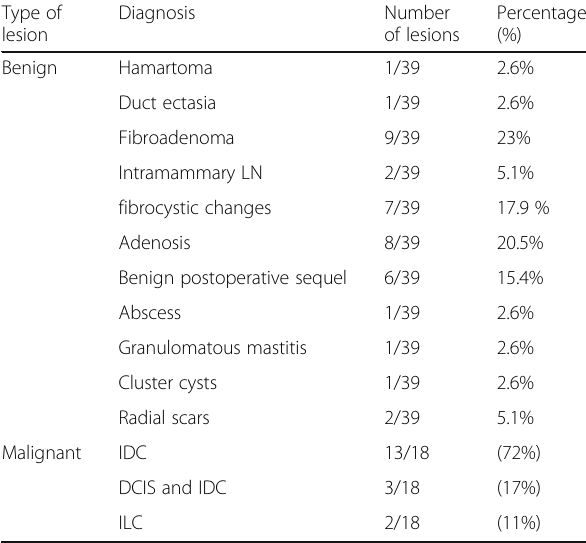
Table 1 The distribution of different pathological entities within